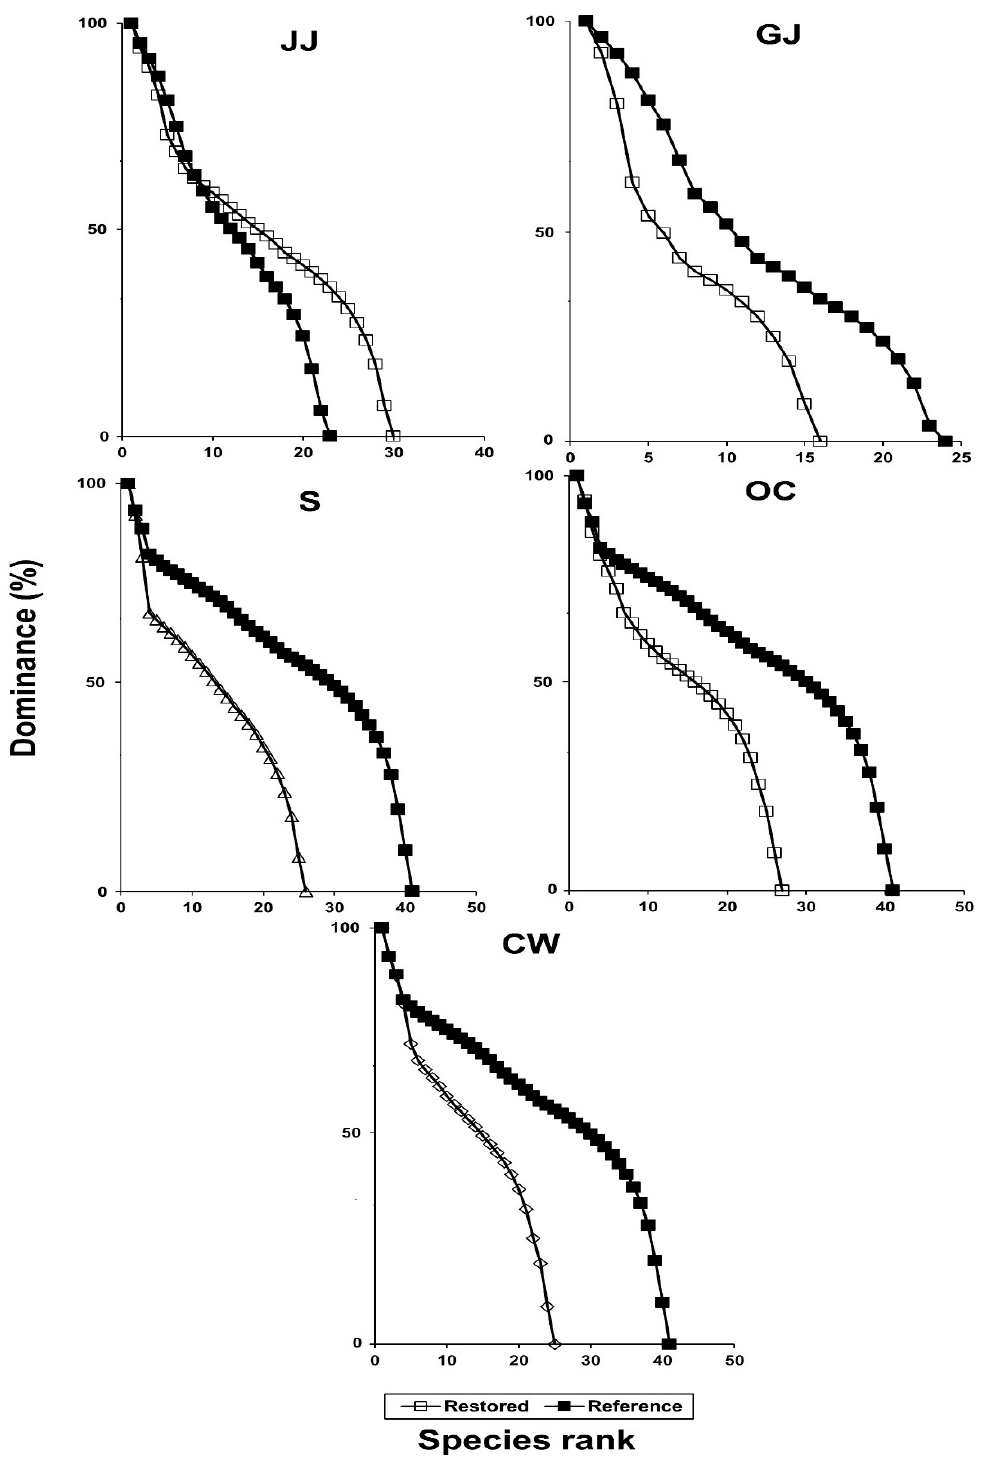
Figure 5. A comparison of the species rank-dominance curves of the vegetation among the re- stored and natural reference rivers. Abbreviated river name is the same as in Figure 3. Reference: natural reference river, Restored: restored river.